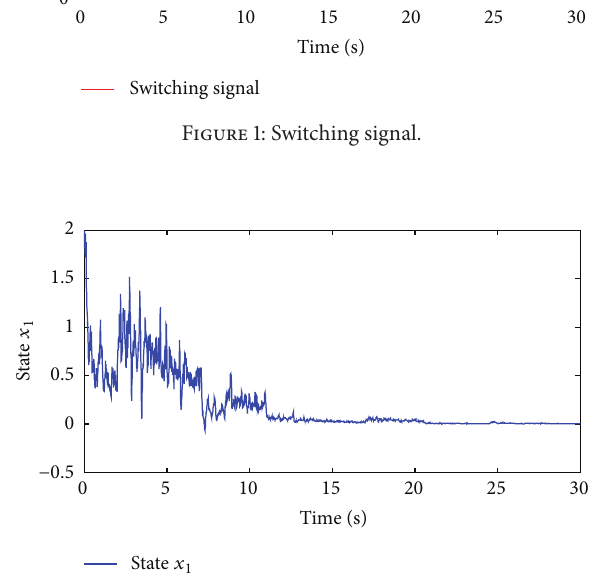
Figure 2: State x 1 of the closed-loop